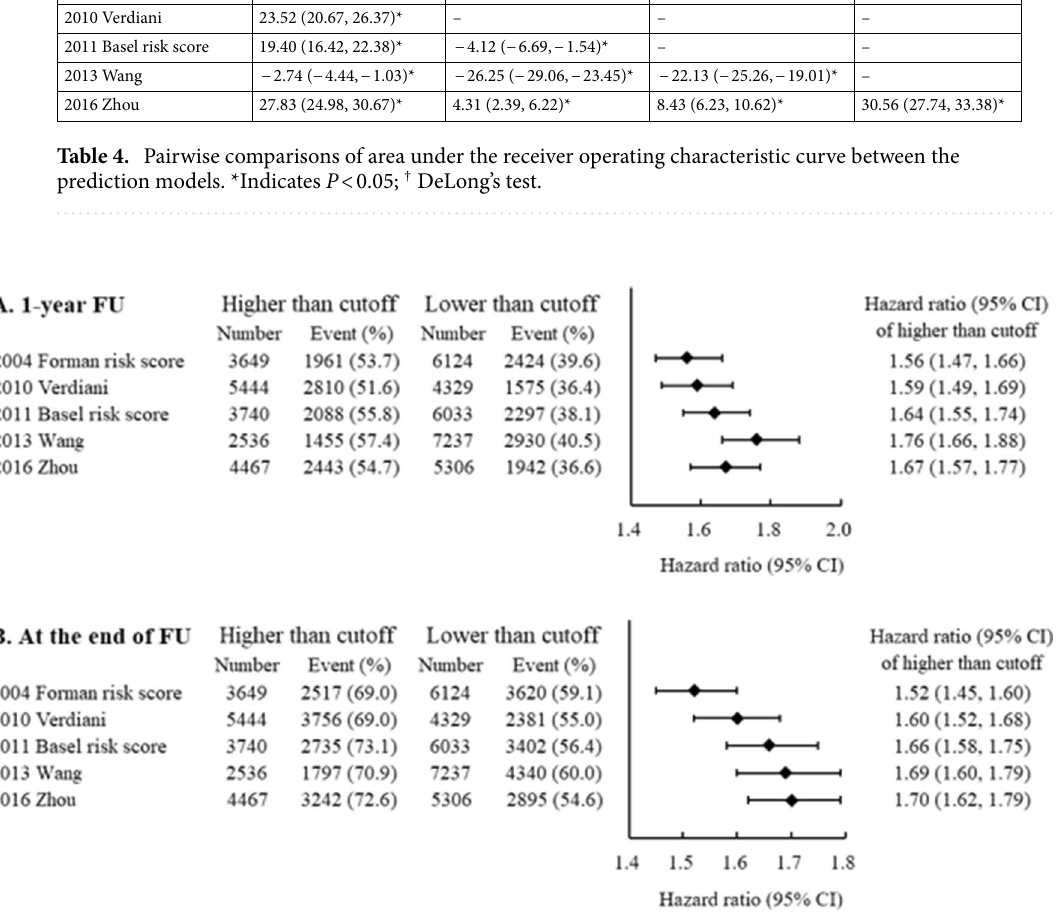
Figure 3. Forest plot showing the association between higher risk scores (above the optimal cutoff) and the risk of MAKEs during 1-year follow-up ( A ) and at the end of follow-up ( B ). MAKEs major adverse kidney